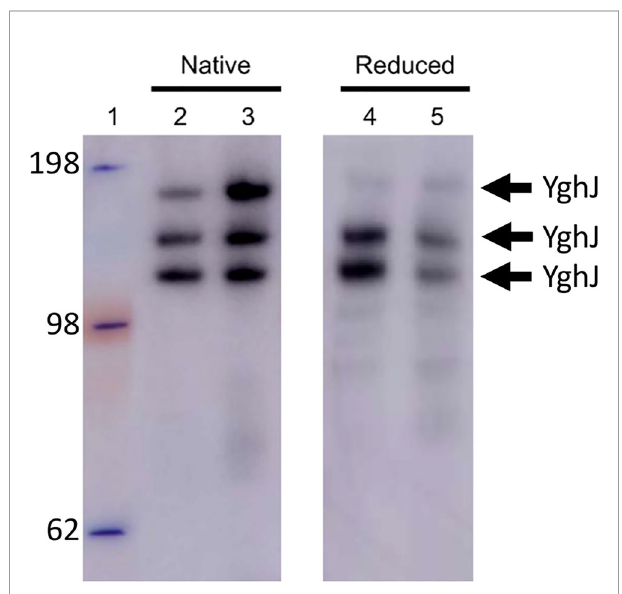
FIGURE 1 | Western blot analysis of puri fi ed glycosylated and non- glycosylated YghJ. Glycosylated and non-glycosylated YghJ was loaded onto a PAGE gel and run under either non-reducing (left panel) or reducing conditions (right panel) to assess the linear and native protein conformations. Molecular weight marker (kDa) was loaded in lane 1. Glycosylated YghJ was loaded in lanes 2 and 4 whereas the non-glycosylated protein variant was loaded in lanes 3 and 5. Chicken anti-FLAG antibodies (diluted x4.000) and HRP conjugated rabbit Anti-Chicken IgY (diluted x5.000) were used to visualize